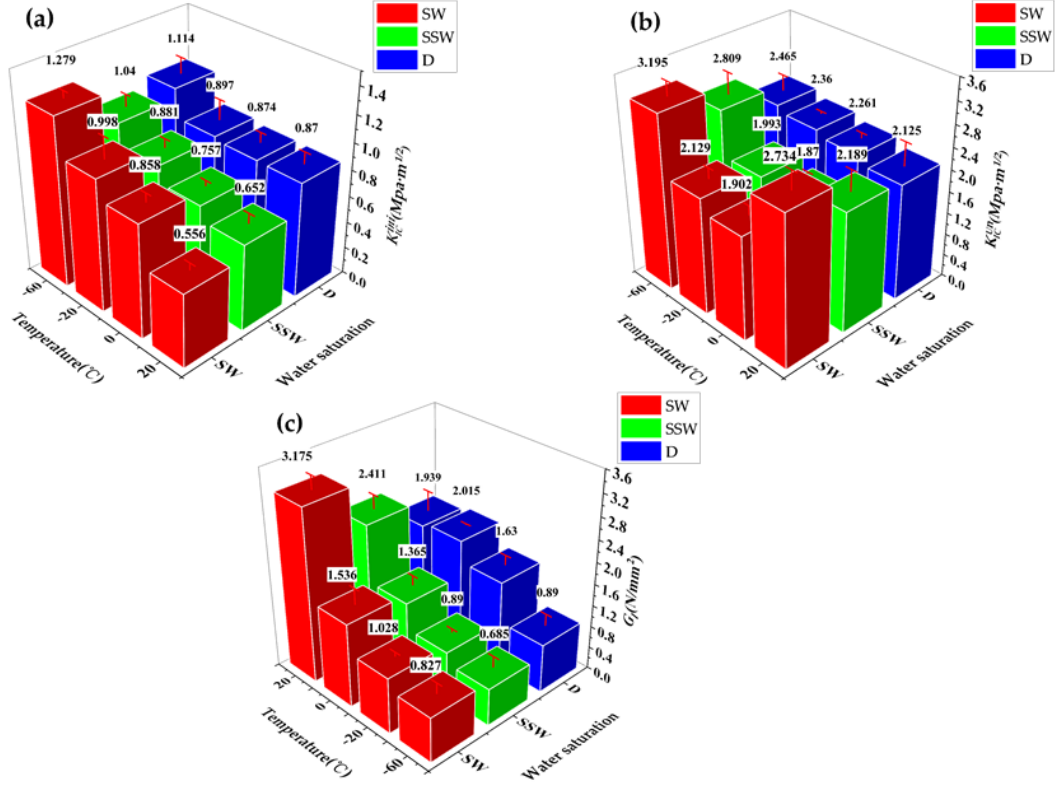
Figure 13. The ( a ) K ICini , ( b ) K ICun , and ( c ) G I varies with temperature at three saturation levels. In the dry state, K ini and K un increased slowly, while G I increased at 0 ◦ C and decreased IC IC at − 20 and − 60 ◦ C. This could be attributed to the decrease in atom distance at